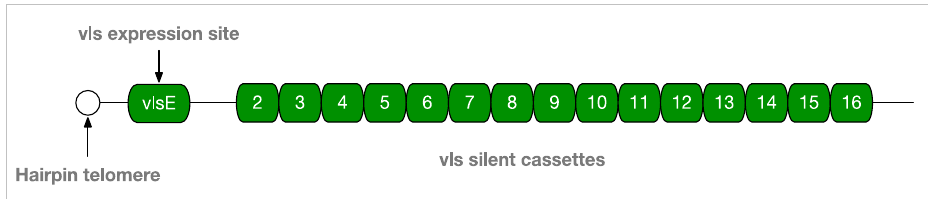
Figure 3. vlsE and Silent Cassettes on Linear Plasmid 28-1 of B. burgdorferi—Borrelia evasion mechanisms counter both innate and adaptive immune responses in order to establish persistent infection in the immunocompetent vertebrate host. Random segments of silent cassettes 2–16 are recombined at the vlsE expression site near the end of lp28-1 to produce surface proteins with a high degree of antigenic variation.